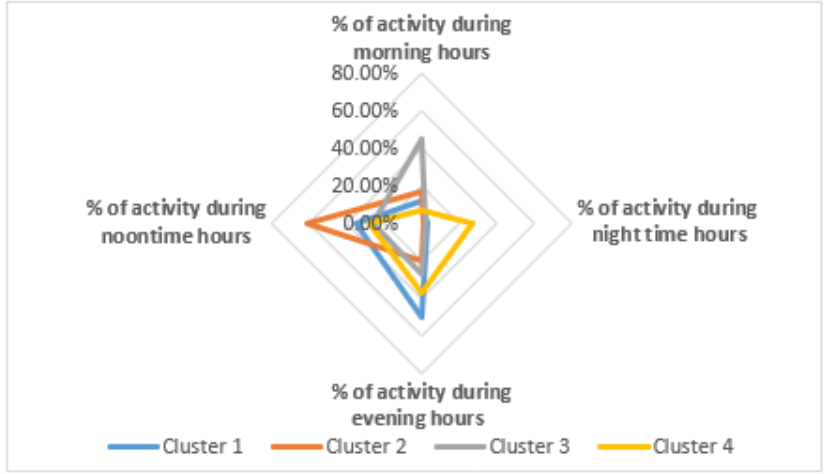
Figure 1. Patterns of use of the flexibility of learning time during the semester.